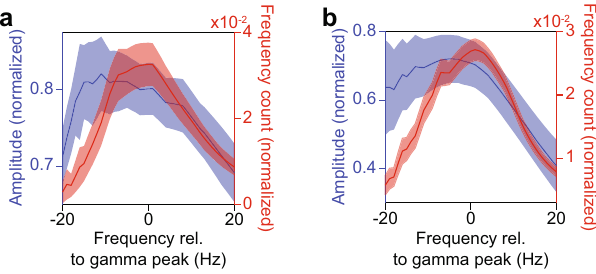
Fig. 5 Cycle-based amplitude-spectra and cycle-frequency distributions. a The x-axis shows duration expressed as its inverse, namely frequency, and after aligning to the gamma peak in the raw power spectrum. The blue curve shows the gamma-half-cycle amplitudes as a function of their duration. The red curve shows the count of detected gamma half-cycles as a function of their duration. These analyses were based on the broadband signal from the last 250 ms of stimulation (see Methods section). Error regions show ±2 SEM based on a bootstrap procedure. b Same as a , but for gamma epochs detected on the fi ltered LFP. Source data are provided in